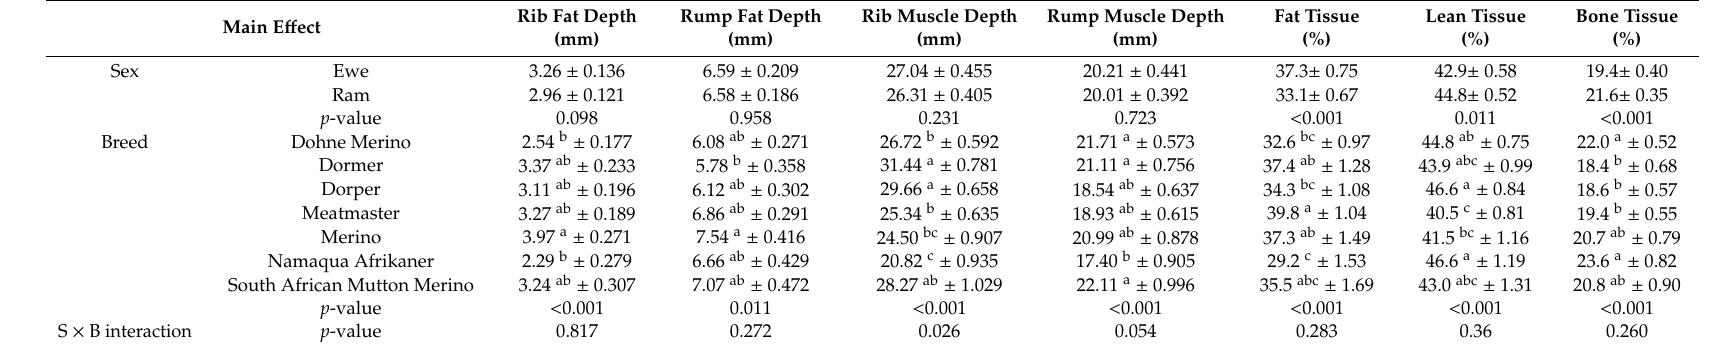
Table 4. Fat and muscle depth and the three-rib tissue composition of A2 carcasses depending on the lamb sex and breed, expressed as the least square means ± standard